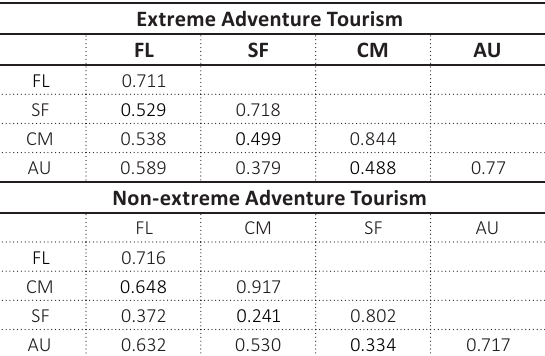
Table 4. Testing the discriminant validity